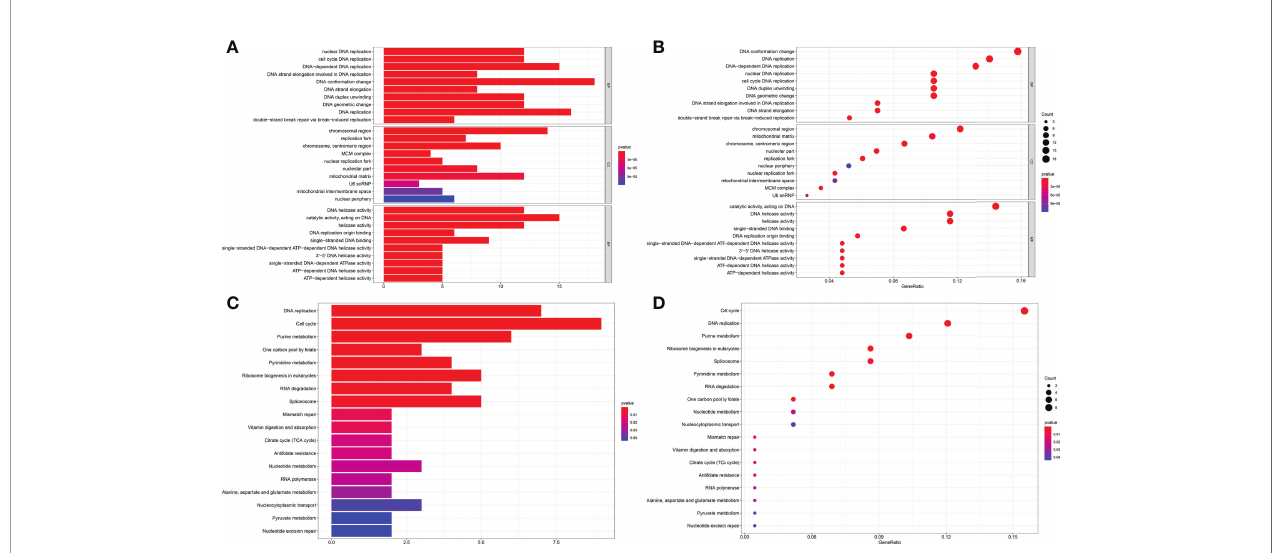
FIGURE 9 | GO terms and the KEGG pathway. (A) Histogram presentation of the top 10 positions of GO terms of target genes in biological processes (BP), cellular components (CC) and molecular functions (MF) of biology; (B) Bubble chart of the top 10 positions of GO terms of target genes in BP, CC, MF; (C) Histogram presentation of pathways related to the differentially expressed genes by the KEGG analysis; (D) Bubble chart of pathways related to the differentially expressed genes by the KEGG analysis.